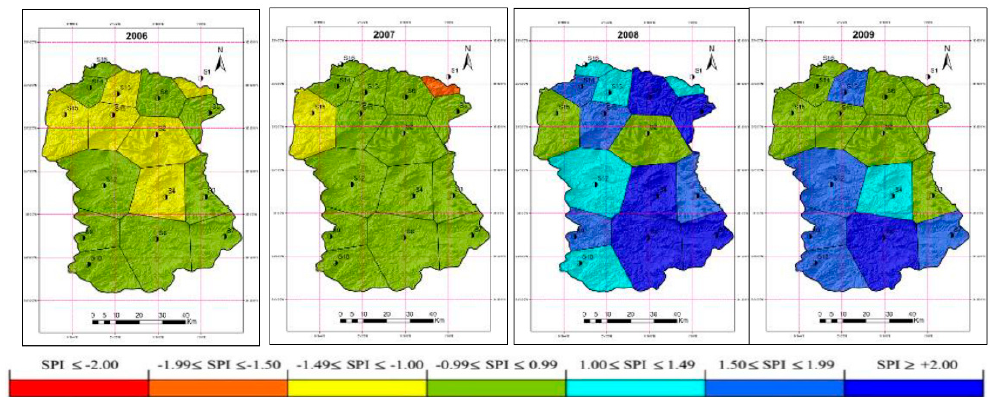
Figure 4. Spatial variability of meteorological drought in the wadi Mina basin.